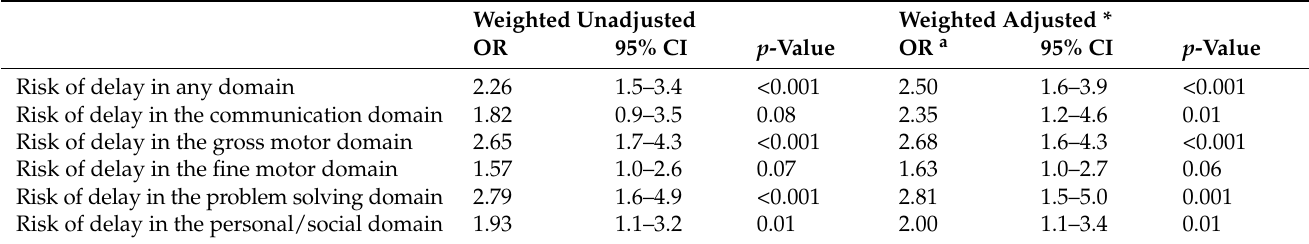
Table 4. Multivariate analysis with an inverse weighting of the association of maternal level of schooling up to 8 years with the risk of delay in the child development